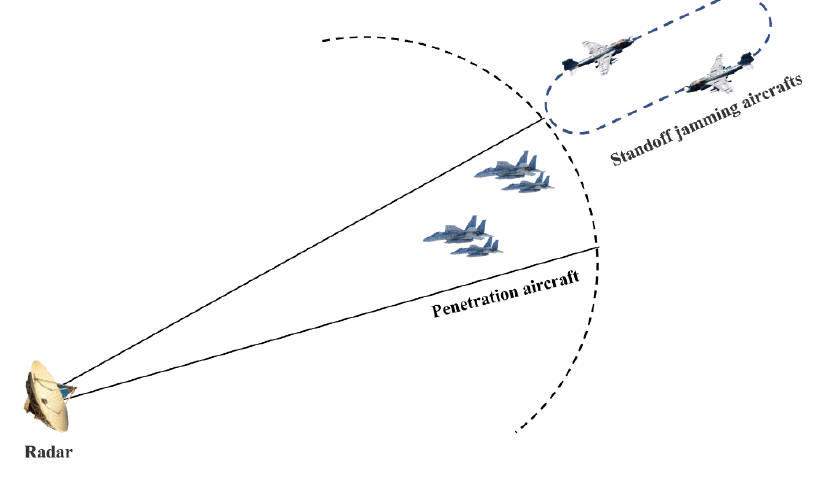
Figure 4. Standoff jamming